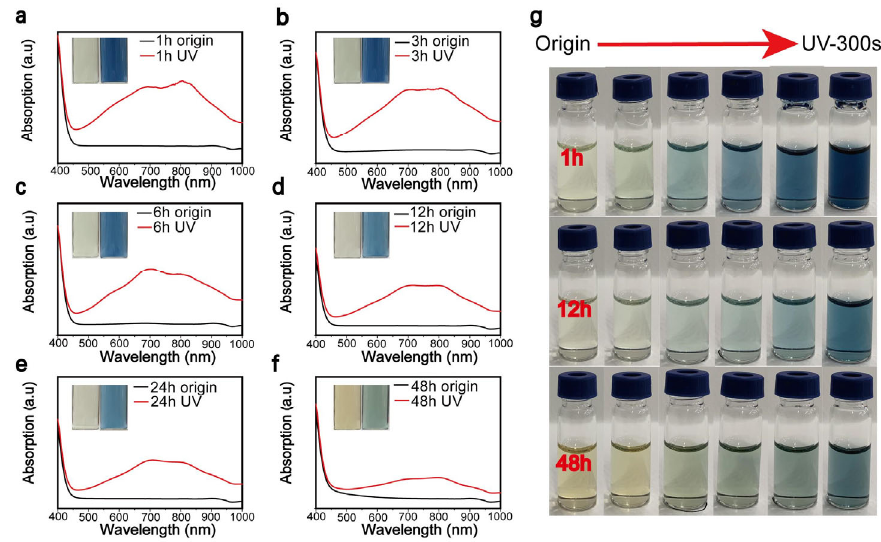
Figure 4. ( a – f ) The absorption spectrum for the MoO 3 ‐ x nanostructure underwent varying reaction times of 1, 3, 6, 12, 24, and 48 h, and origin samples were irradiated for 5 min by Xenon lamp to create UV samples. ( g ) Photographs of MoO 3 ‐ x nanostructures irradiated by Xenon lamp for 300 s.